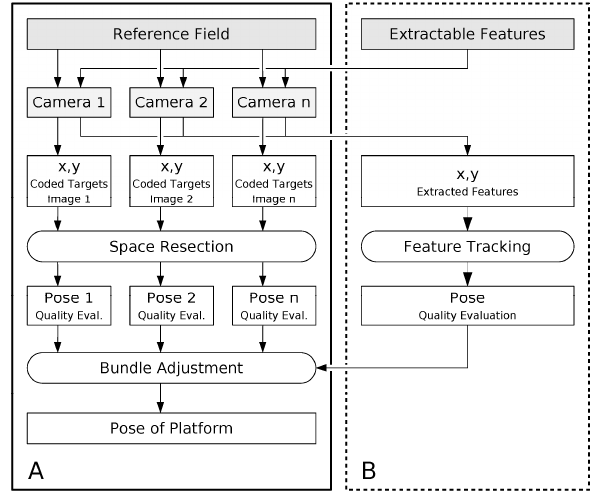
Figure 2. Process overview. System at stage 1 (see A) which will be extended to a stage 2 to use feature tracking for supporting pose estimation